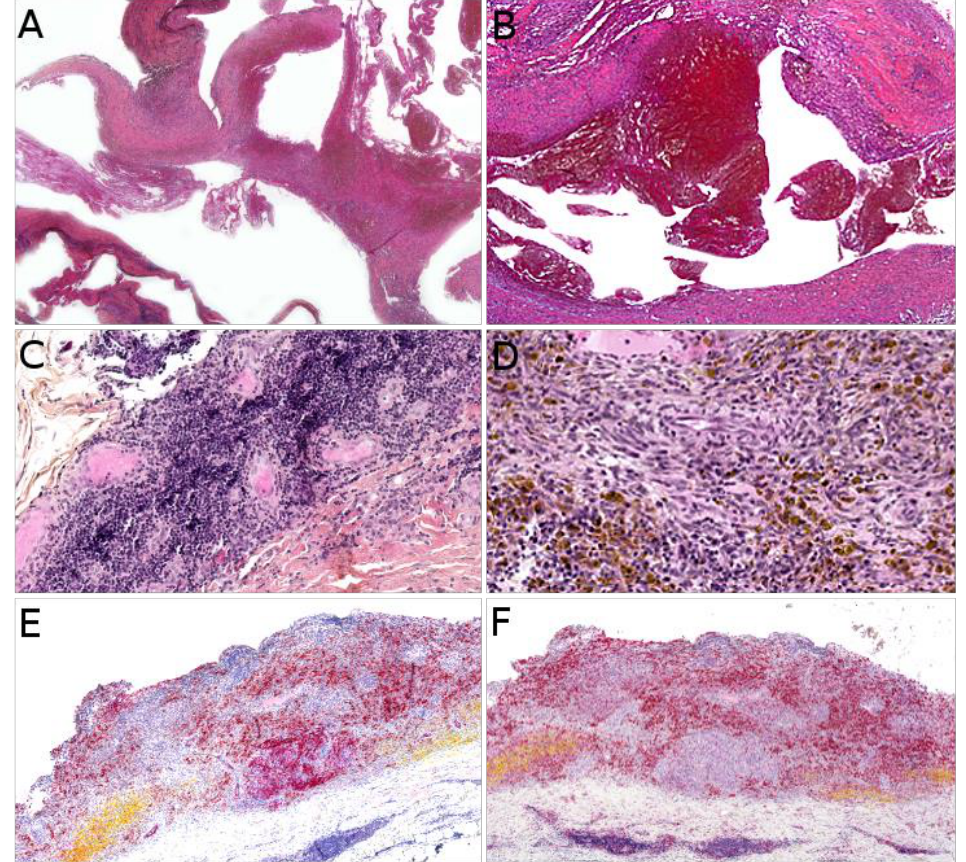
Figure 2. Angiomatoid fibrous histiocytoma: ( A ) Pseudo-angiomatous spaces (×25); ( B ) blood-filled pseudo-angiomatous space (×25); ( C ) dense lymphocytic infiltrate at the periphery of the tumor (×25); ( D ) histiocytoid tumor cells and hemosiderin deposits (×200); ( E ) positivity for desmin (×25) and ( F ) for CD68 (×25).